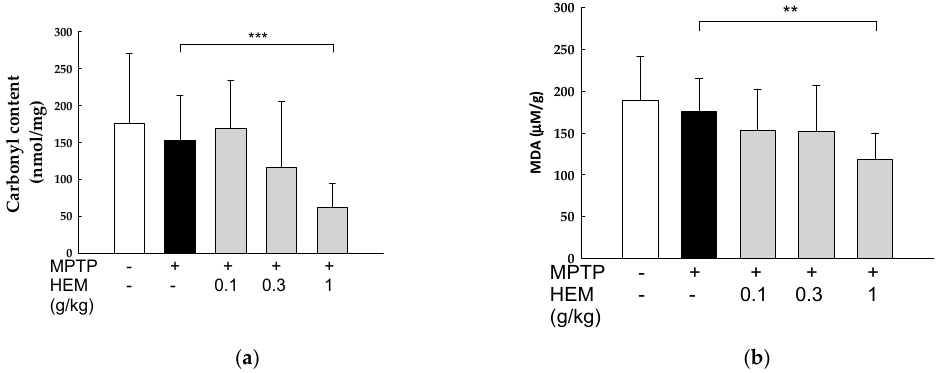
Figure 6. E ff ects of MPTP treatment in the presence or absence of HEM in the brains of mice on the ( a ) protein carbonyl content and ( b ) MDA levels. A signi fi cant decrease in the PC and MDA levels was found in the brains of mice obtained from treatment with a high concentration of HEM (1 g/kg) compared with the MPTP group. Values are expressed as mean ± SD. ** p < 0.01;*** p < 0.001 com- pared with the MPTP − treated group.